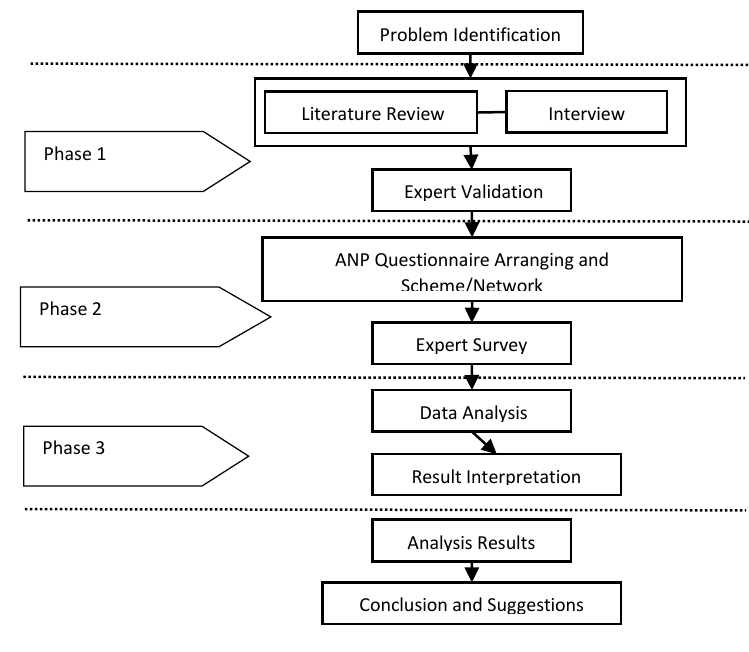
Figure 1 ANP Research Phases